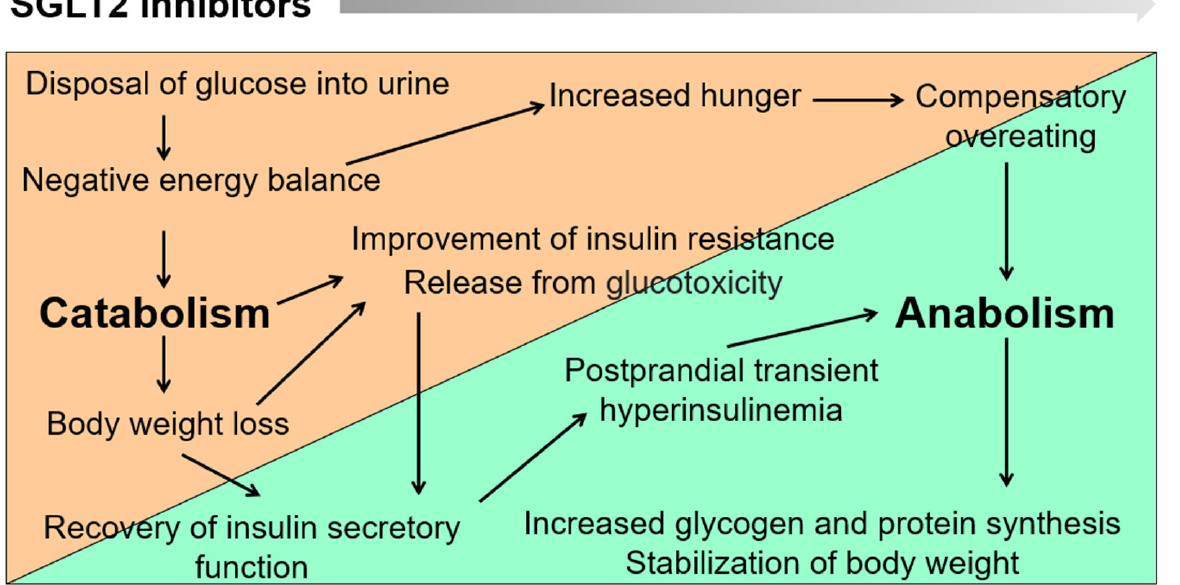
Figure 2. Dynamic changes in metabolic set points and establishment of new homeostasis after sodium-glucose co-transporter 2 (SGLT2) inhibitor administration. During SGLT2 inhibitor treatment, the energy balance dynamically shifts from catabolism to anabolism over time. SGLT2 inhibitors cause glucose to be excreted by the kidneys, resulting in a negative energy balance. To compensate for the reduced glucose levels, fat and muscle are broken down and become substrates for glycogenesis (catabolism). Once body fat mass decreases, insulin sensitivity improves, hunger increases, and compensatory overeating occurs. Furthermore, pancreatic β cells recover from glucotoxicity and are activated, so after meals, transient hyperinsulinemia occurs, which promotes the synthesis of fat, glycogen, and protein (anabolism).